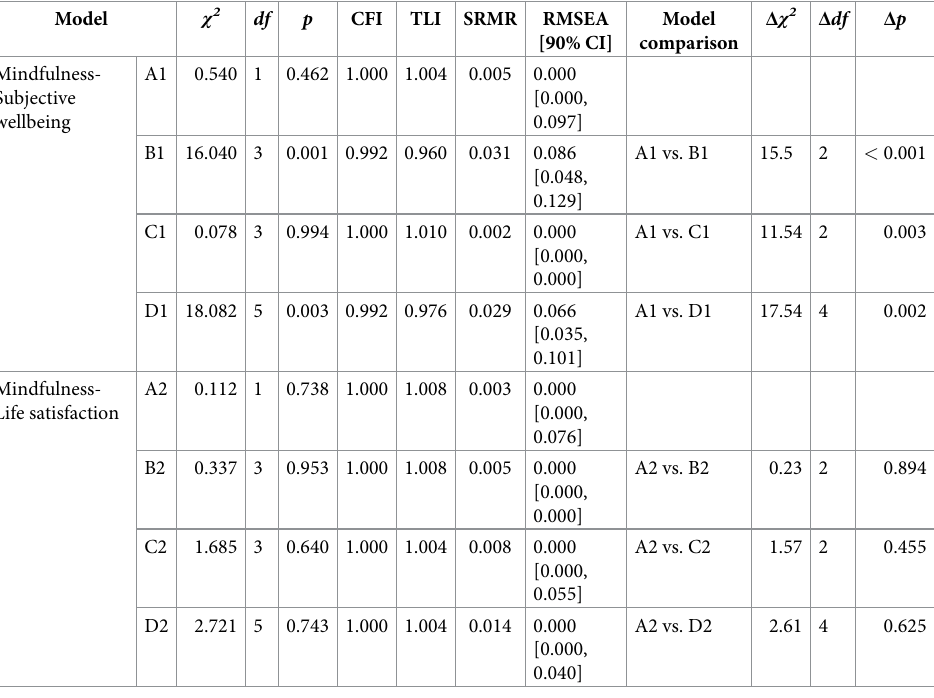
paths to be equal, Model C: constrained cross-lagged paths to be equal, Model D: constrained both autoregressive paths and cross-lagged paths to be equal.